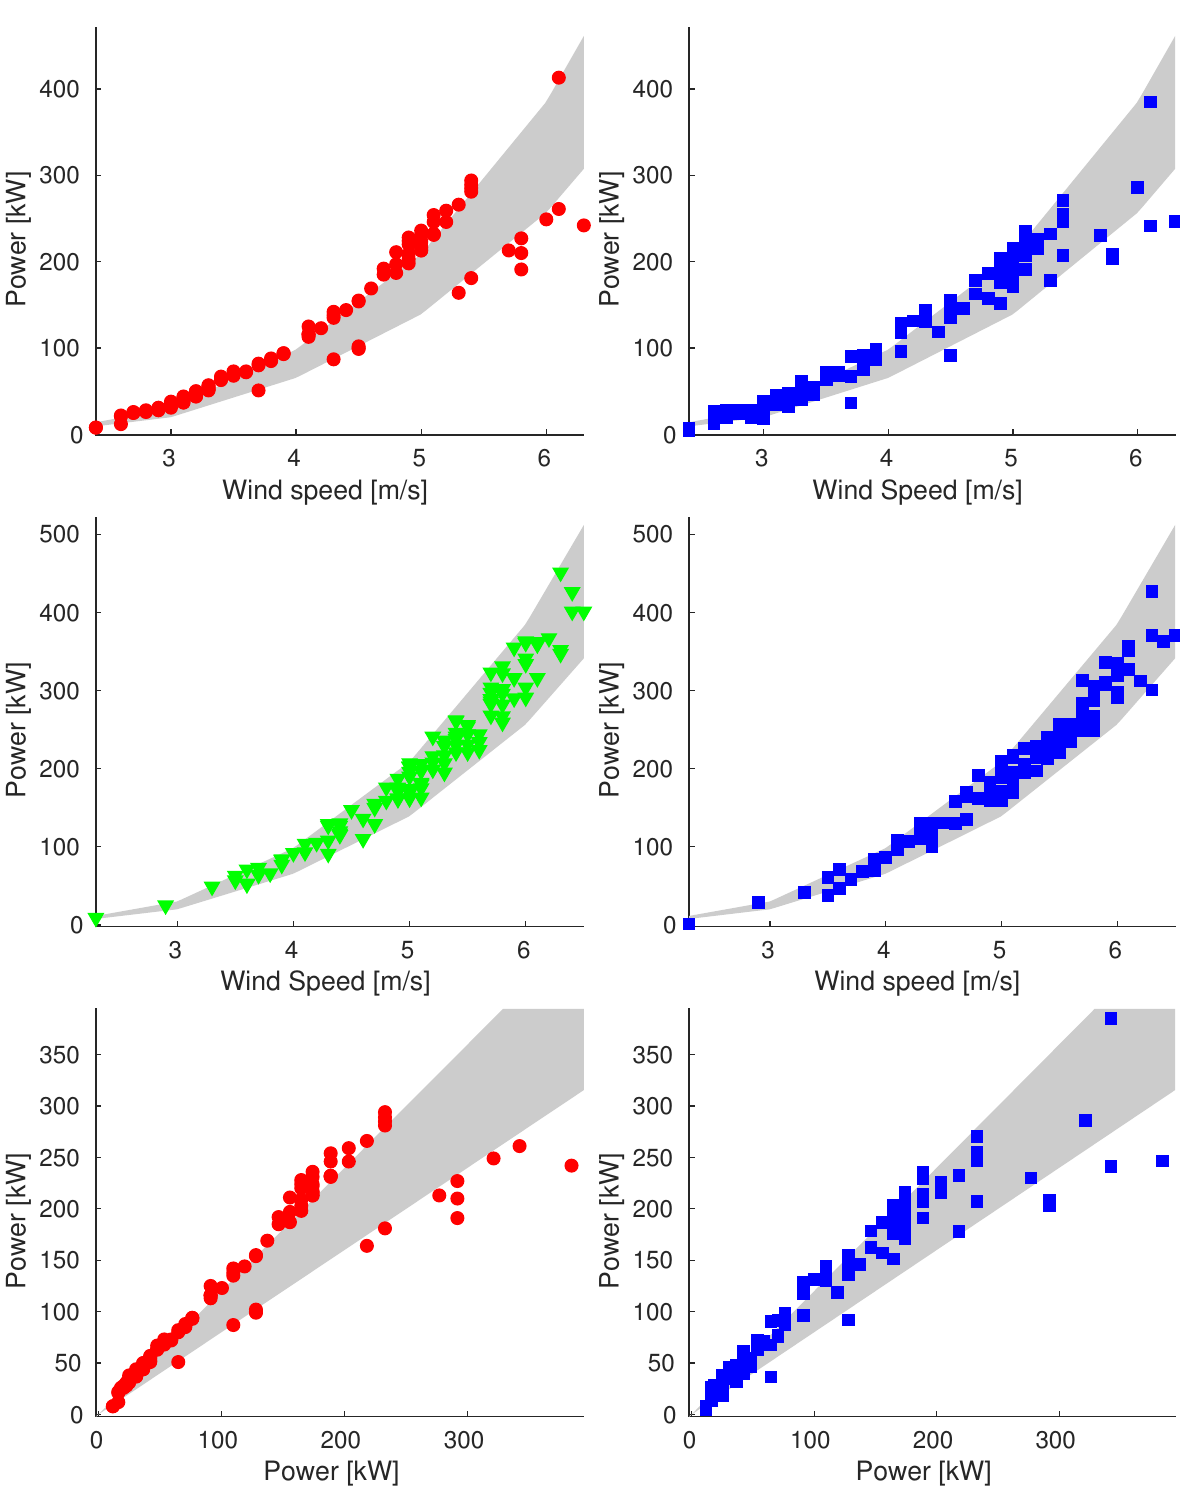
Figure 5. Plot of reconstructions for data points of 16 May ( Sample_90 ). We compare original data (on the left ) and reconstructed values (on the right ). We show plots of power vs. wind speed of rejected and validation data ( up and middle , respectively) and plot of power vs. ideal power of rejected data ( bottom